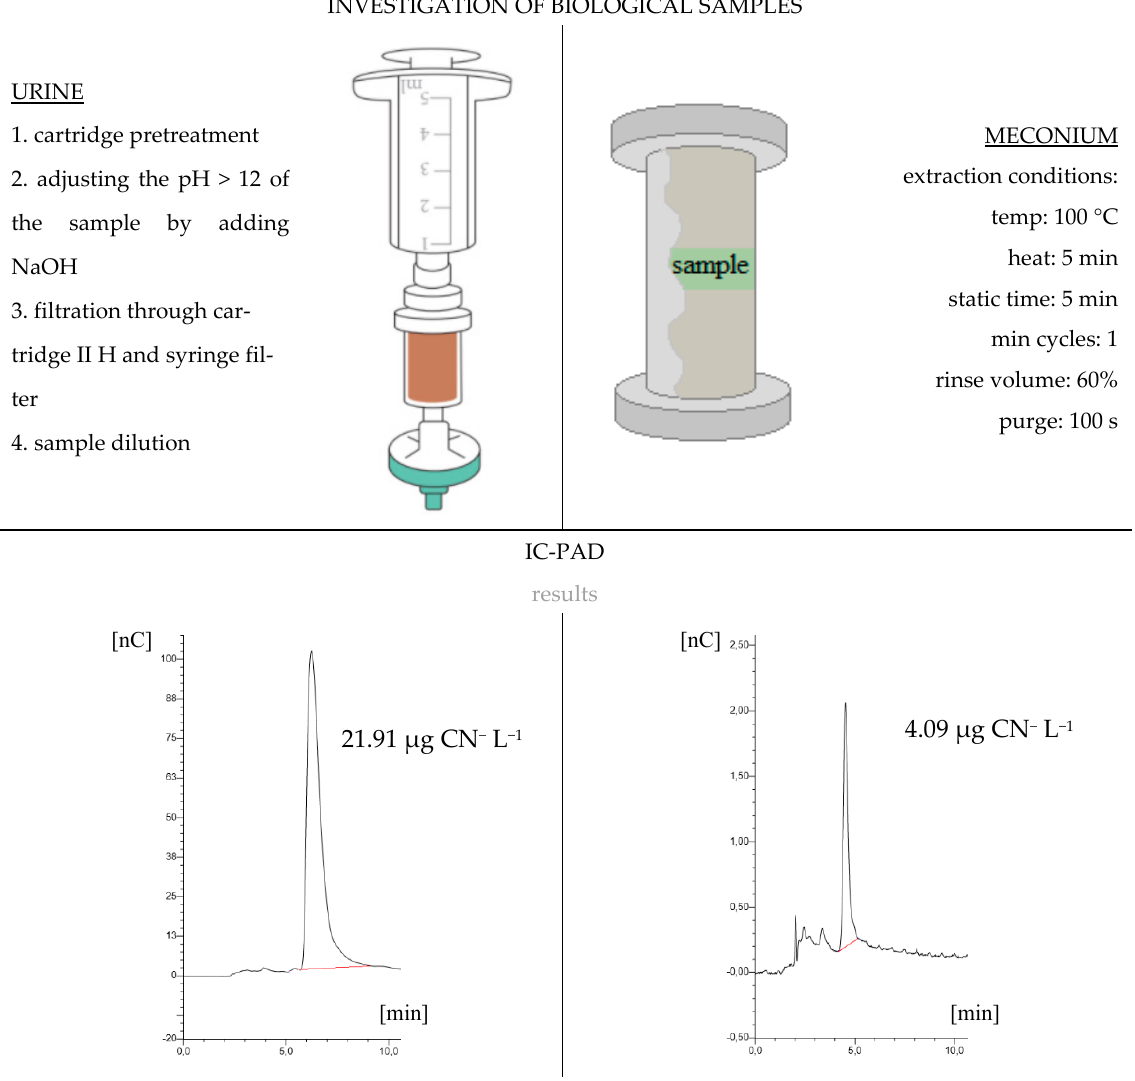
Figure 1. Diagram of the analytical procedure for determining CN- by using IC-PAD .